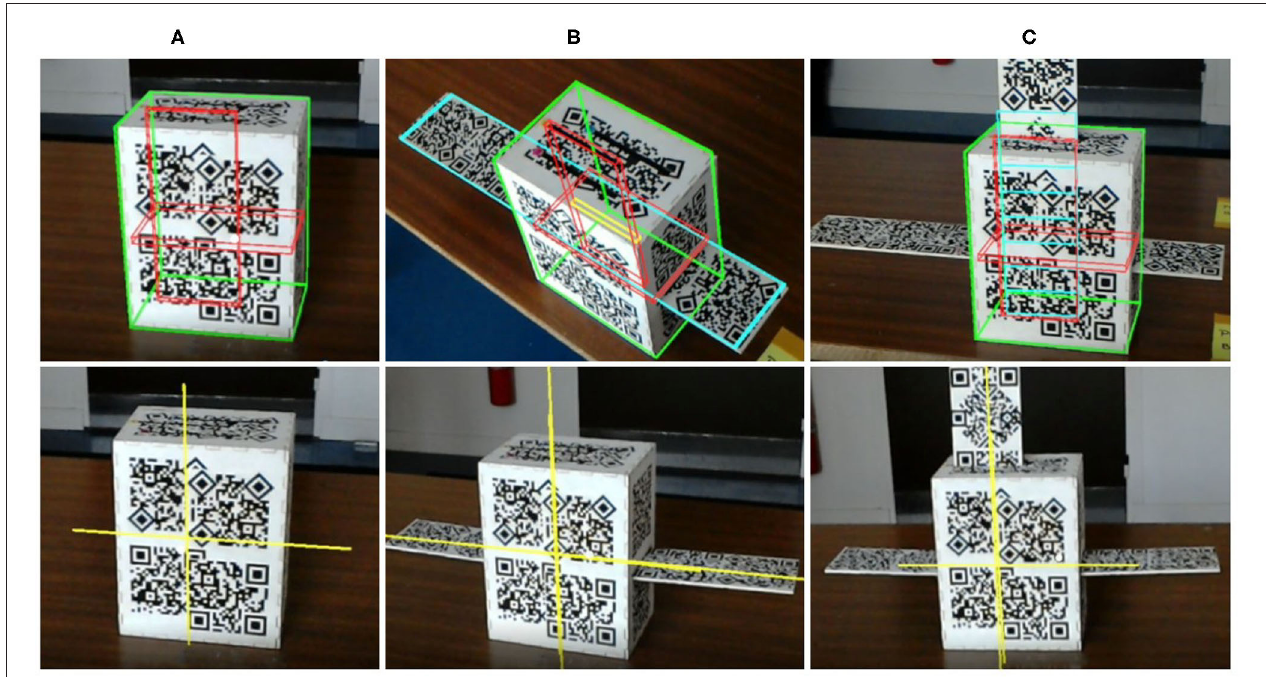
FIGURE 2 | The First-Person View (FPV) on the HoloLens (captured from the Mixed Reality Viewer) displaying both AR overlays (per line), at the different stages of the task (per column). First line, the wireframe overlay, second line, the axes overlays. (A) Before starting the task. (B) After operation 1. (C) After operation 2.